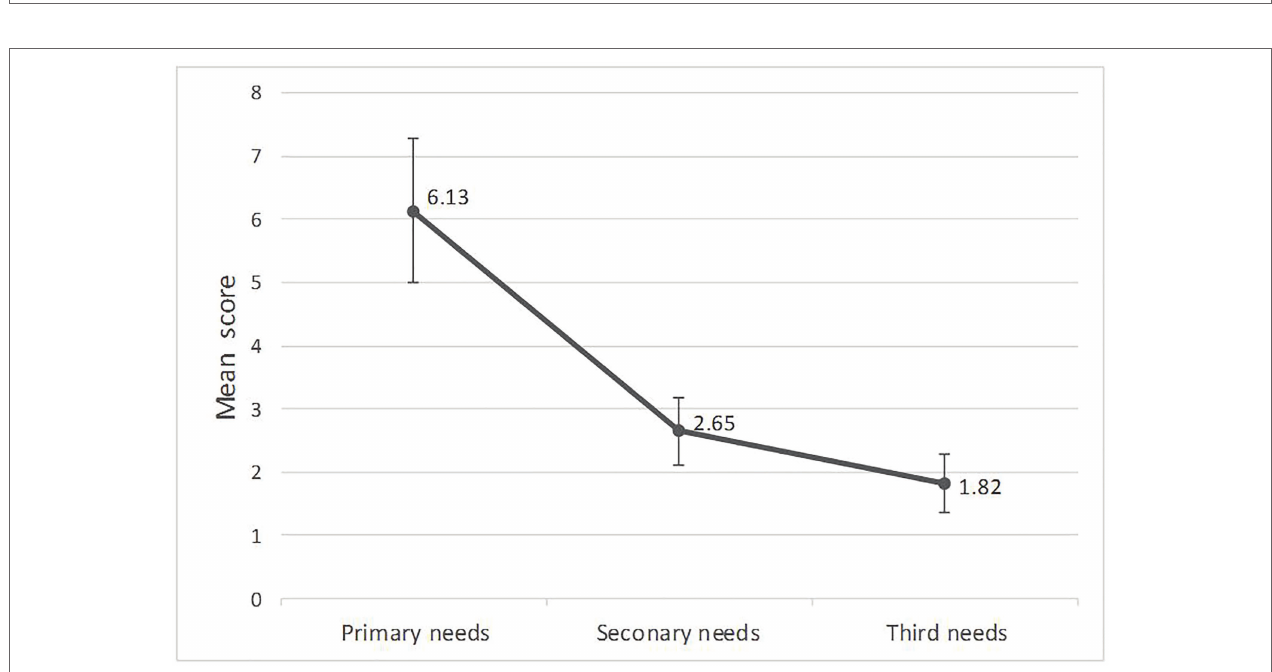
FIGURE 1 | The matching degree of top-3 needs of each participant’s.